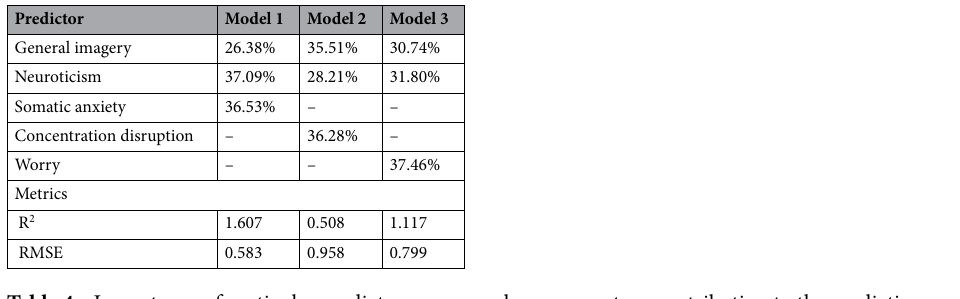
Table 4. Importance of particular predictors, expressed as a percentage contribution to the prediction result for each model, as well as the basic metrics of the trained predictive models.